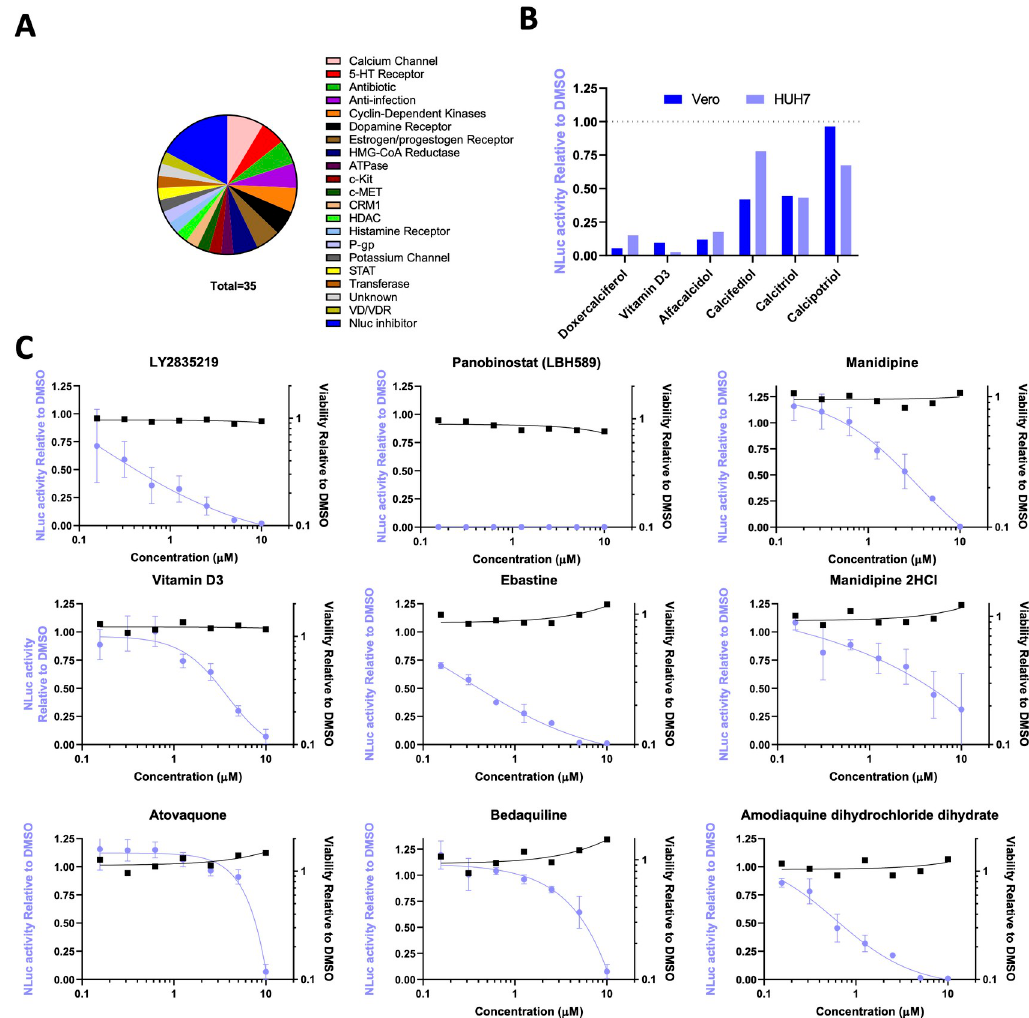
Fig 5. Dose response of SARS-CoV-2 inhibitors. A) Summary of the inhibitor class of the 35 compounds identified in both the Vero and HUH7 screens. B) Effects of vitamin D related compounds from the APExBIO DiscoveryProbe library on NLuc activity in the Vero and HUH7 screens. C) Dose responses to the 9 compounds in HUH7 cells. Cells were treated and infected as described in Fig 4D . NLuc activity relative to DMSO controls are shown in blue, and viability relative to DMSO are shown in black. N = 2 independent repeats are